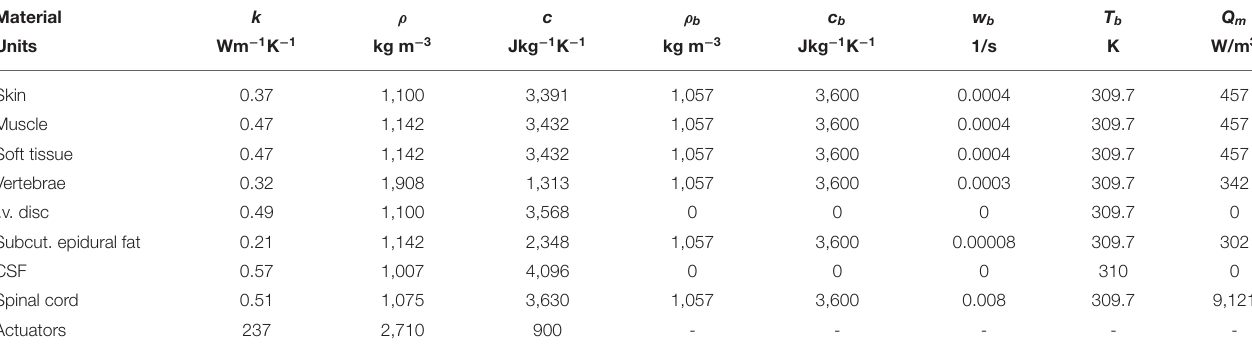
TABLE 1 | Thermal properties of the tissues and sources comprising the computational model developed here to estimate temperature gradients during thermal massage. Material